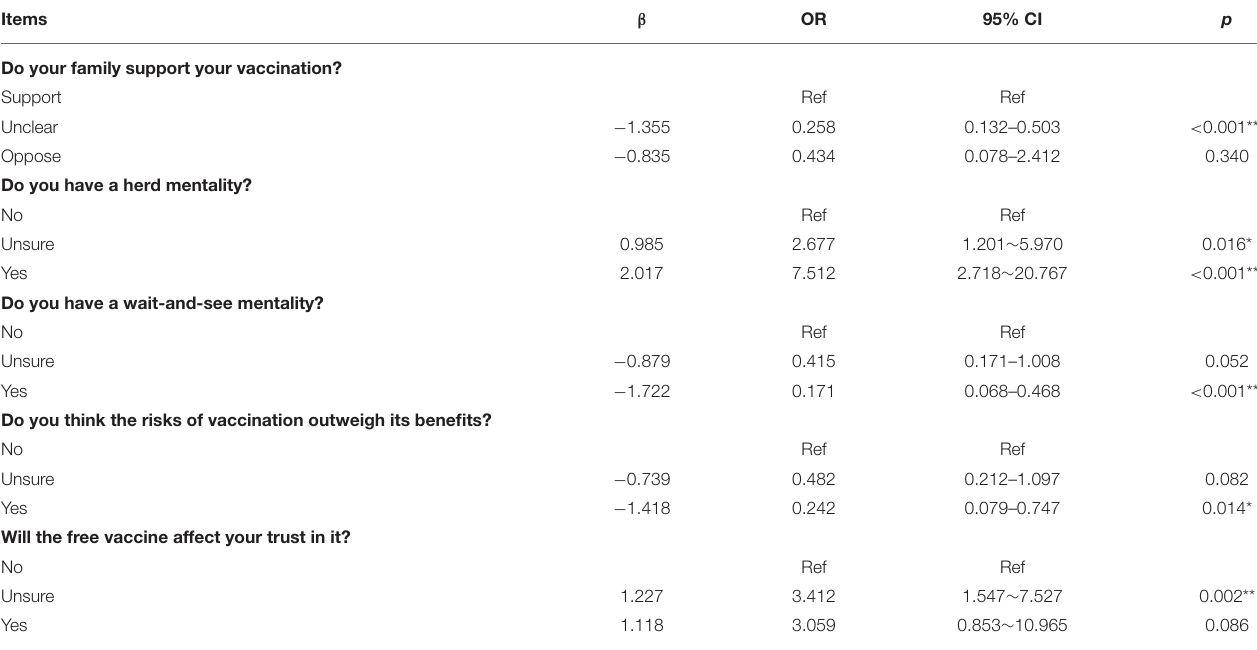
In the table: the second column: β is the maximum likelihood estimate of the regression coefficient; the third column is the estimated value of the odds ratio (OR); the fourth column is the upper and lower limits of the 95% confidence interval of the odds ratio OR; the fifth column is the P-value of the Wald χ 2 test; * p < 0.05; ** p < 0.01; *** p <